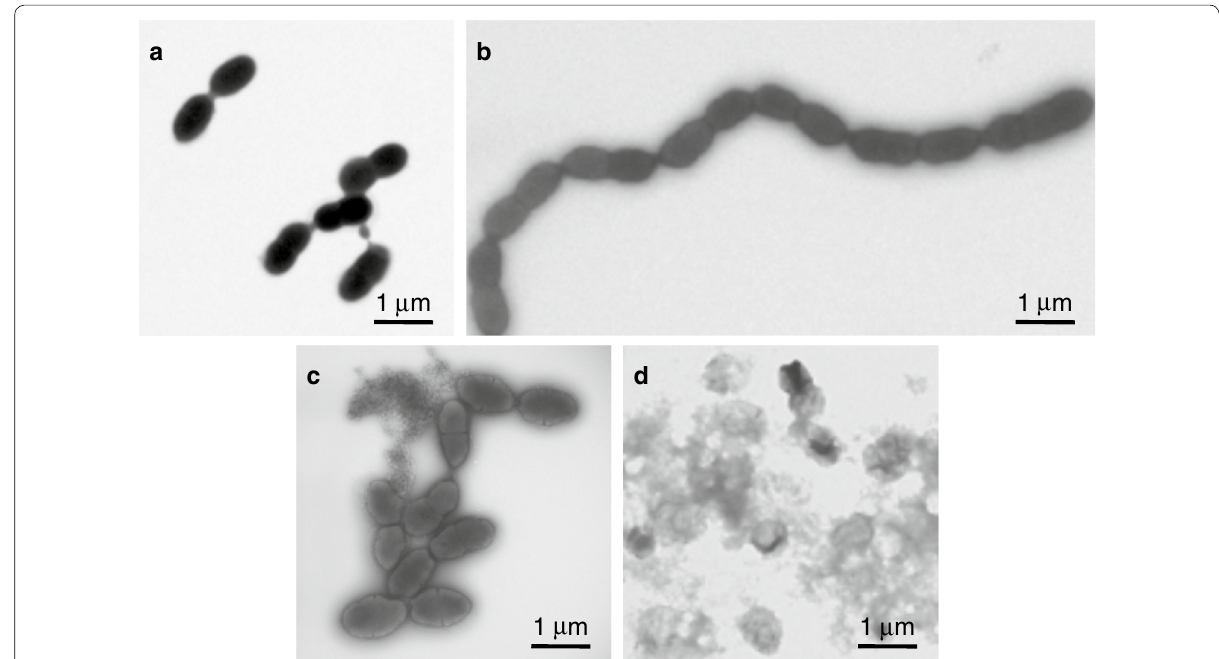
Fig. 5 TEM analysis with negative staining of S. pneumoniae R6 cells cultured in the presence or absence of the Natto peptide. The cells were cultured in TH broth containing 5% (v/v) horse hemolysate in the absence ( a , c ) or presence ( b , d ) of the Natto peptide (64 μg/mL). After 4 h ( a , b ) or 8 h ( c , d ) of incubation, the cells were harvested and observed TEM after negative